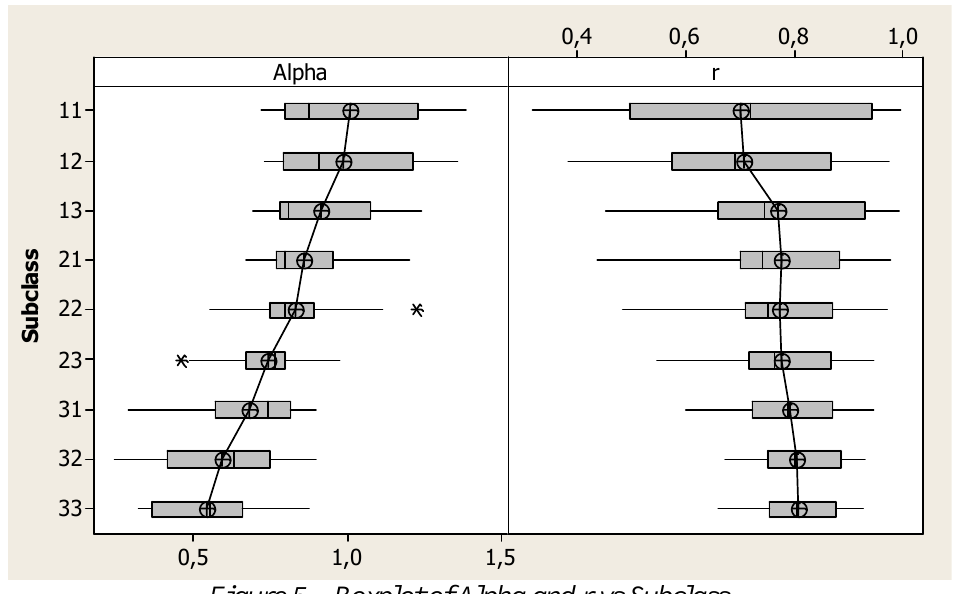
Figure 5 – Boxplot of Alpha and r vs